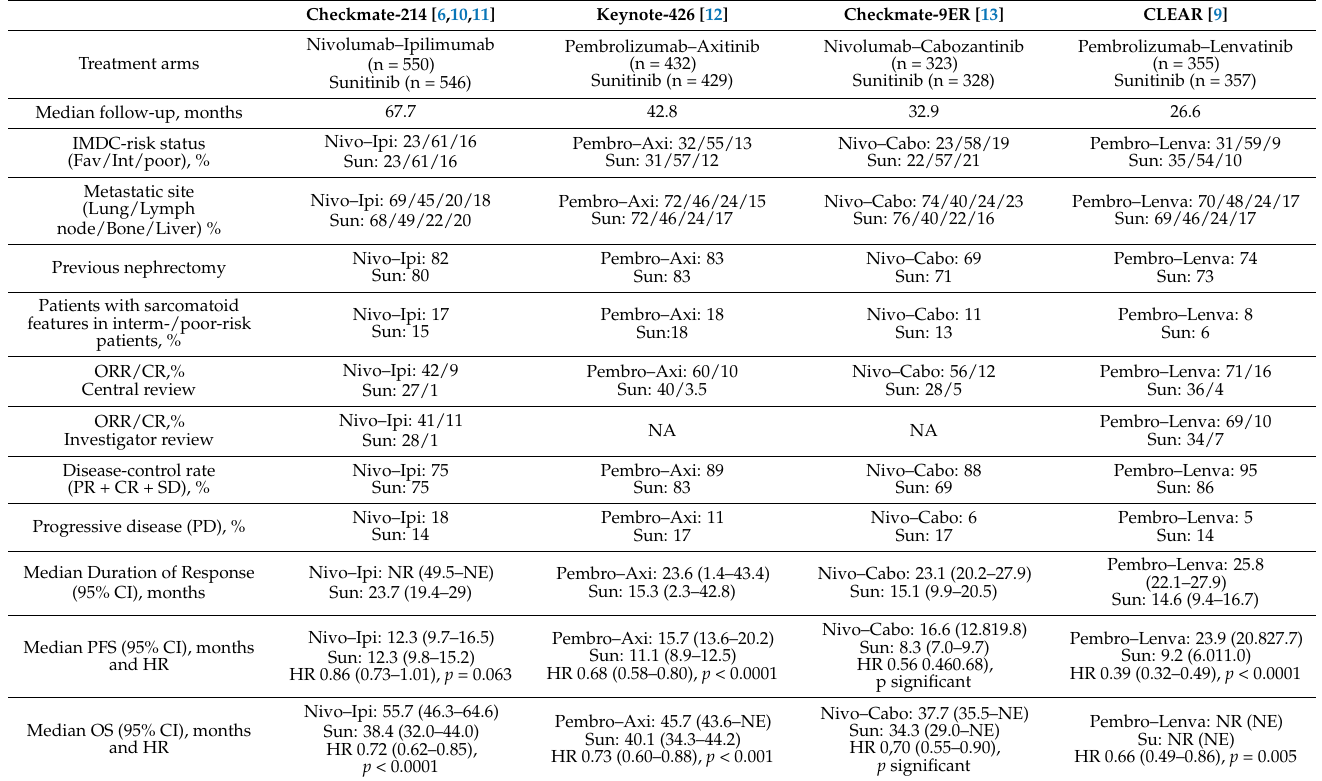
Table 1. Main results from large phase III trials in ccRCC first-line metastatic